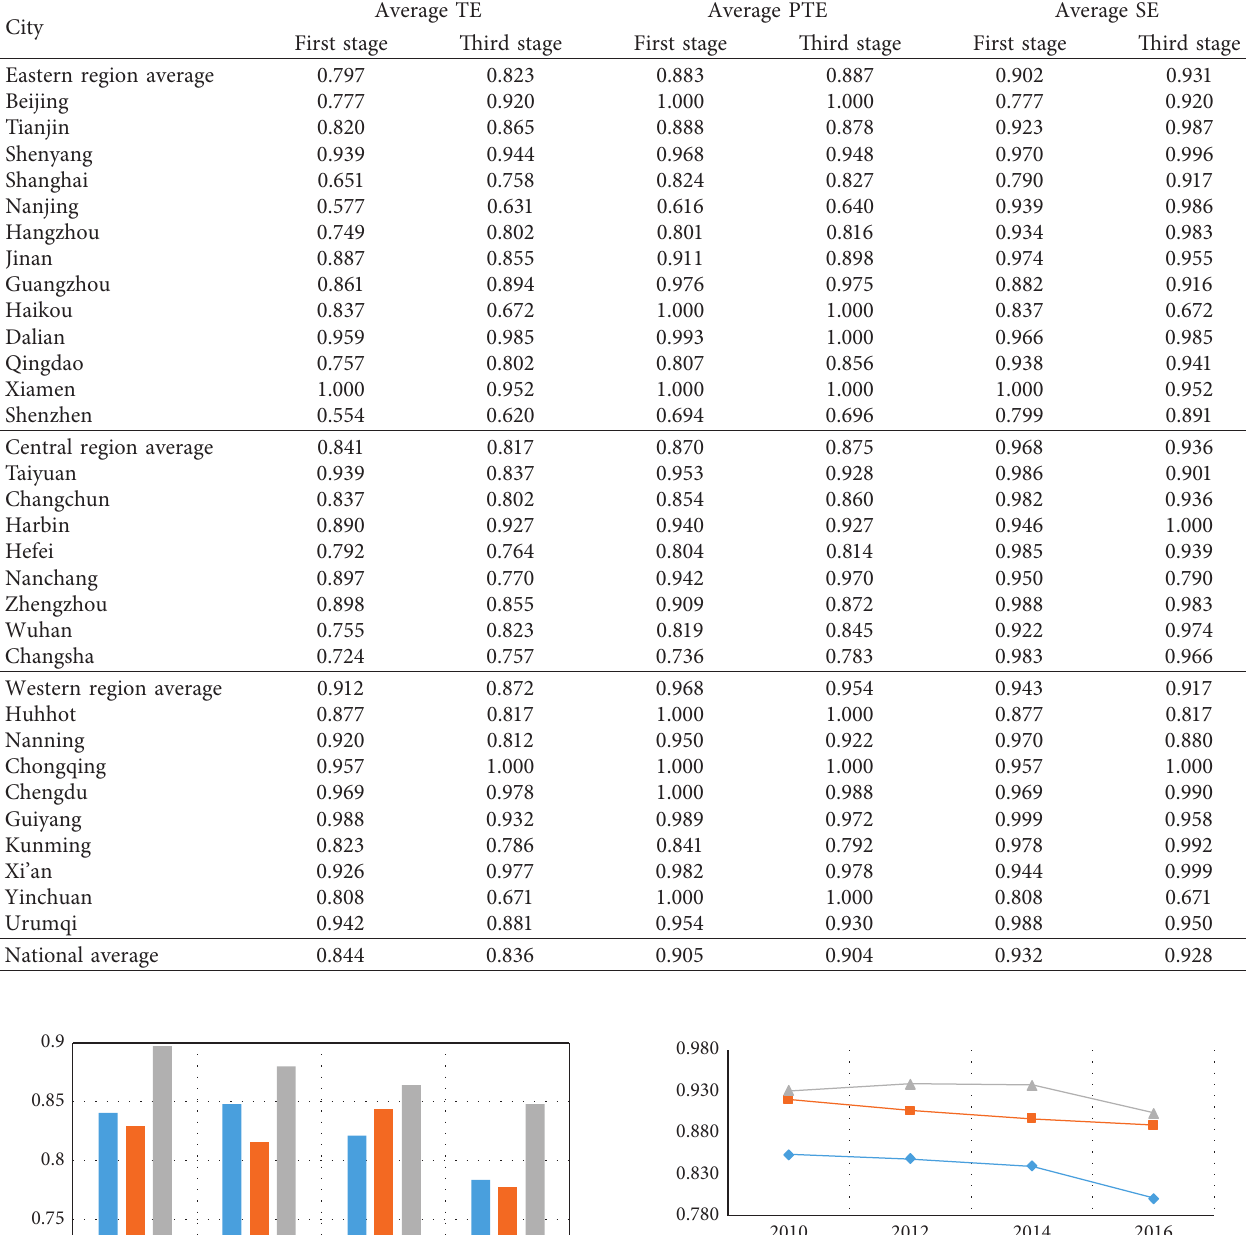
Table 5: Comparison between the results of the first stage and the third stage.